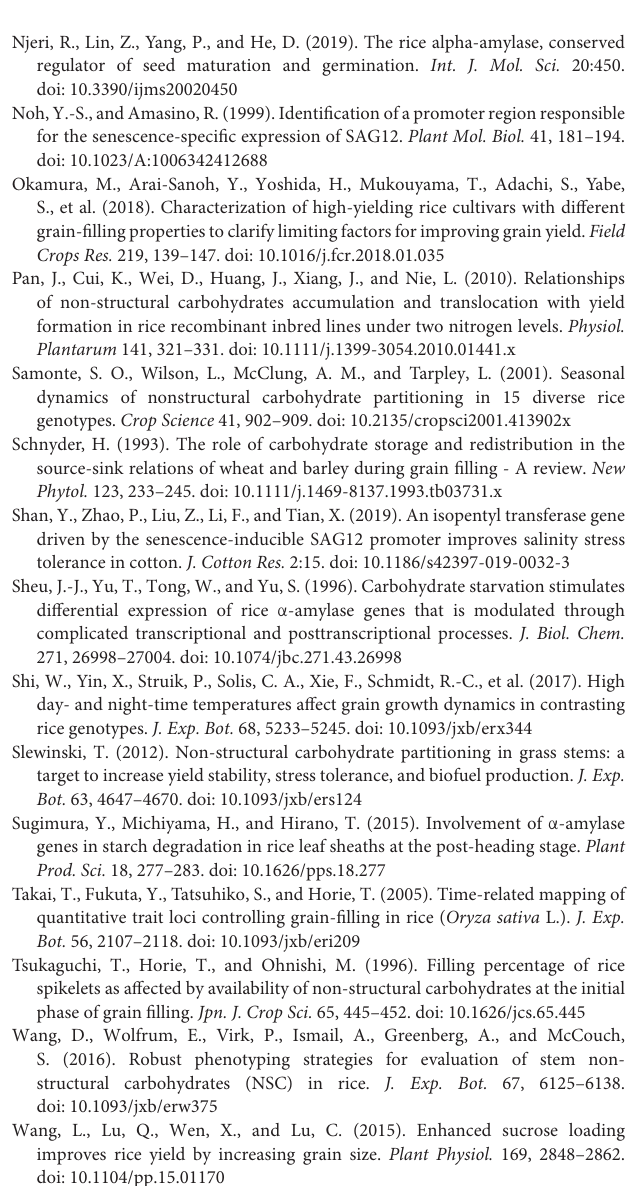
Supplementary Table 1 | The period of rice growth at Changsha during the summer season. Supplementary Table 2 | The period of rice growth at Sanya during the winter